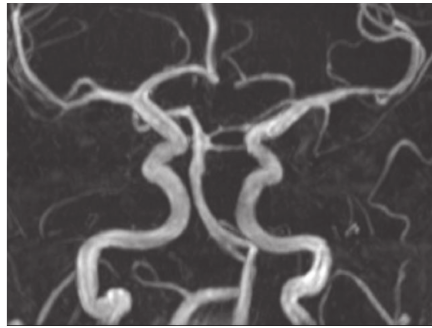
Figure 3: MR angiogram demonstrating patent left MCA. However, if we compare it to the right MCA, there still seems to be some residual stenosis. This MRA was done, a few hours after the initial CT angiogram and at the time patient started to show some fluctuating improvement in his